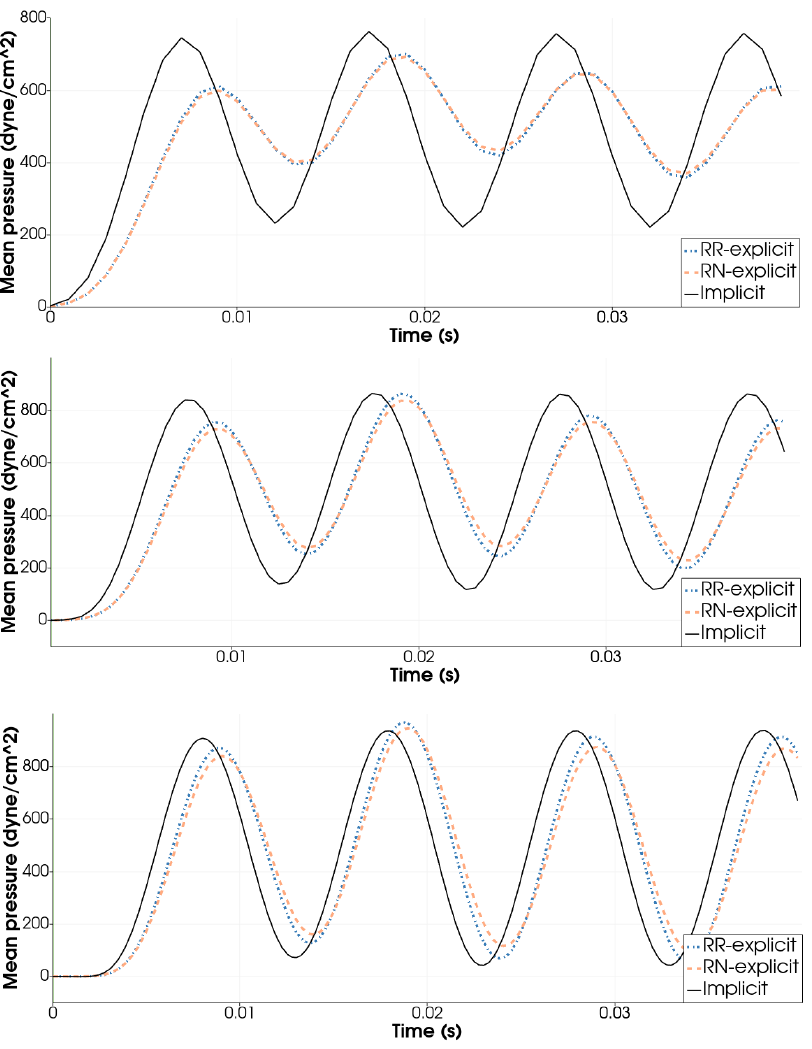
Figure 1. Mean pressure at section z = 2.5cm for different values of ∆ t . Top: ∆ t = 0.001 s; Middle: ∆ t = 0.0005 s; Bottom: ∆ t = 0.00025 s. Test